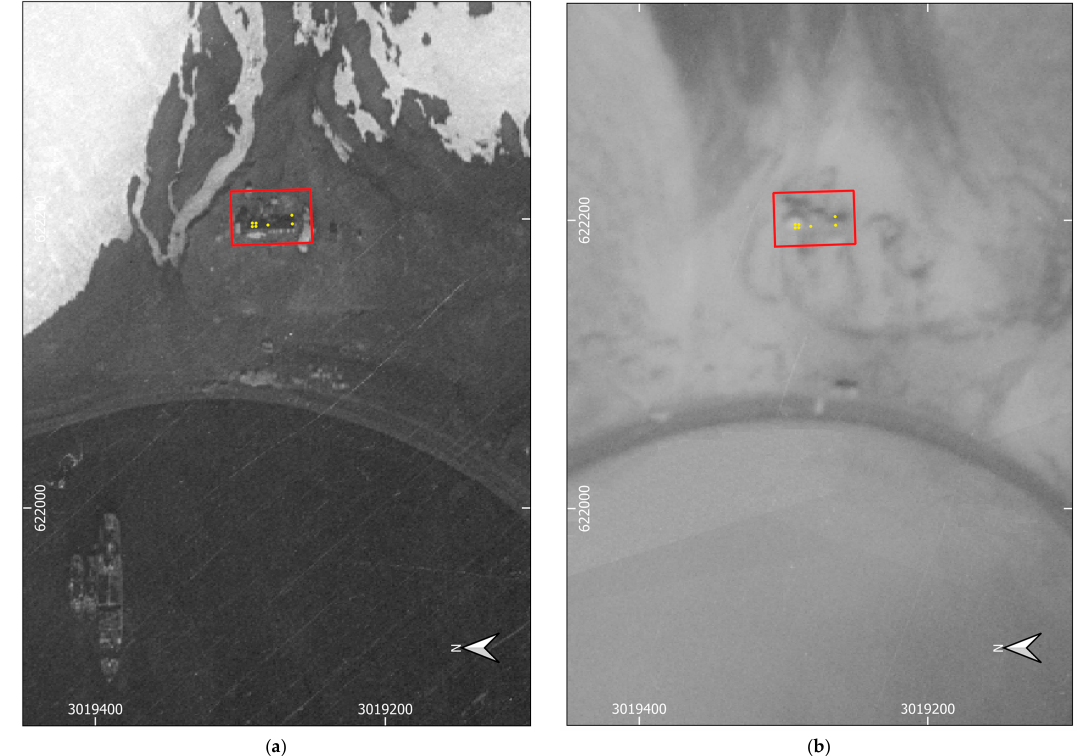
Figure 8. Chilean base in 1956 ( a ) and 1968 ( b ). Ground control points are coloured yellow, coinciding with the corresponding features, in WGS84–UTM20S, and red polygon delimiting the main building. Therefore, horizontal differences should be statistically significant with a 95% confi- dence level above 4.8 m and should be lower in features with expected immobility.